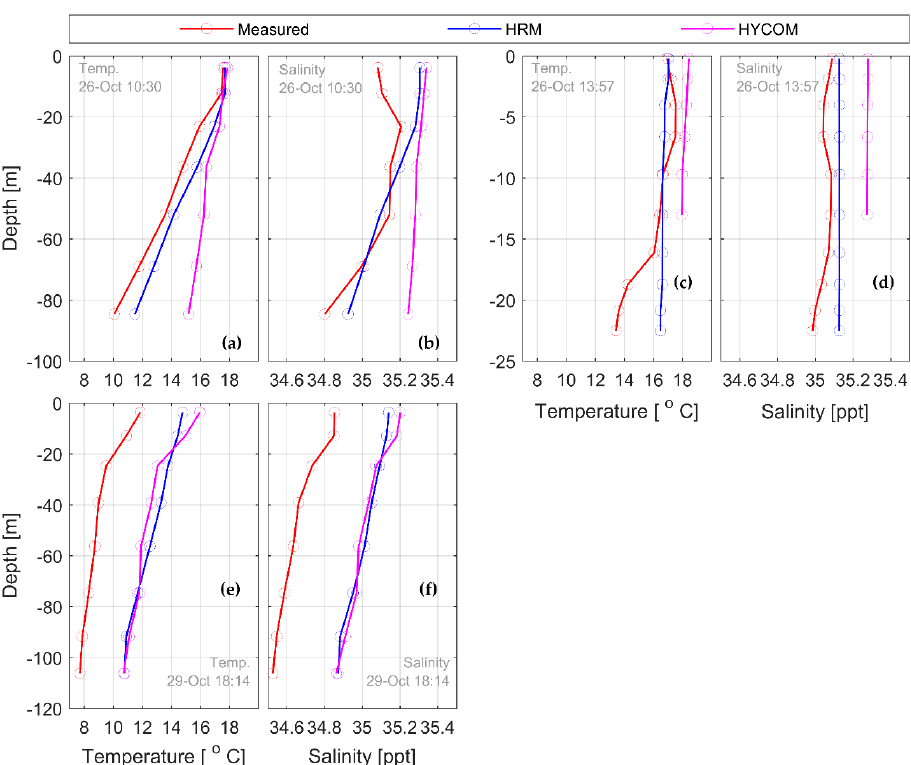
Figure 5. Quantile-quantile plot of near-surface ( a , b ) and near-bottom ( c , d ) velocity components at CU4, near Gordon’s Bay.